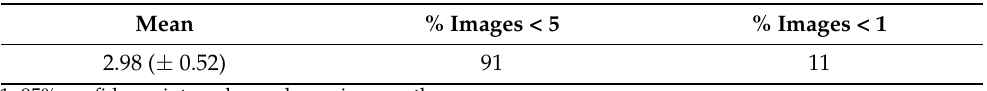
Table 5. Summary statistics for mean ∆ E ∗ and their WTM approximation.